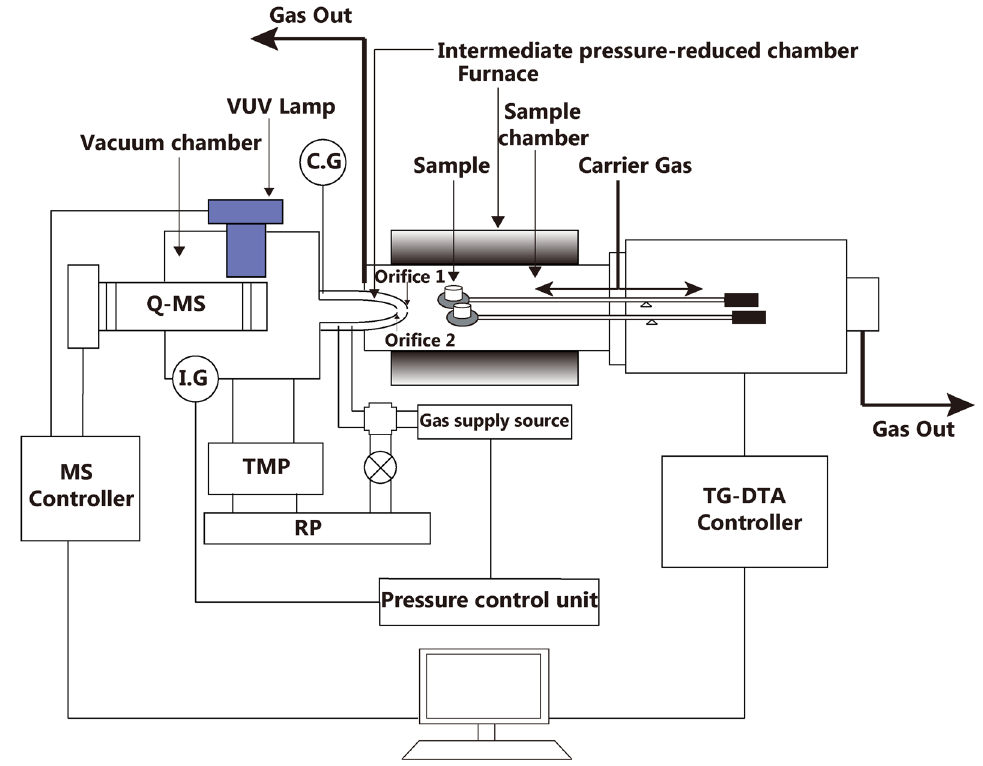
Fig. 8 Schematic diagram of TG–DTA–EI/PIMS system using a skimmer type interface. ( IG ion gauge, CG crystal gauge, TMP turbo molecular pump, RP Rotary